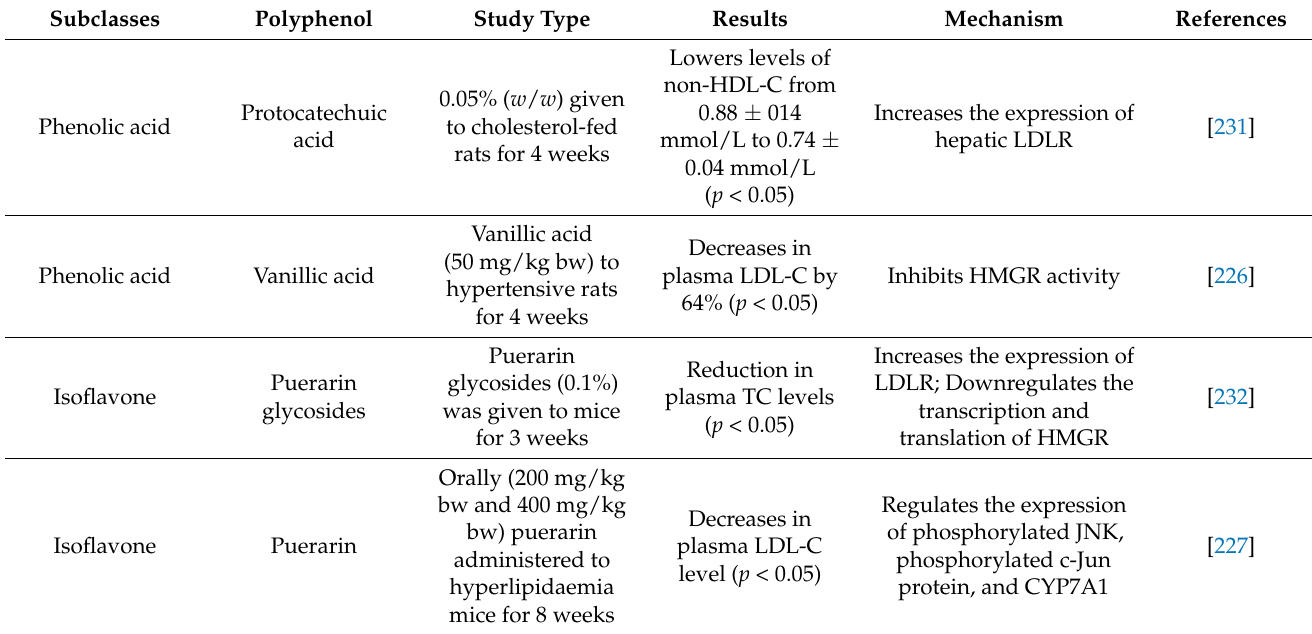
Table 4. Effect of other polyphenols on LDL-C and their mechanism based on in vivo